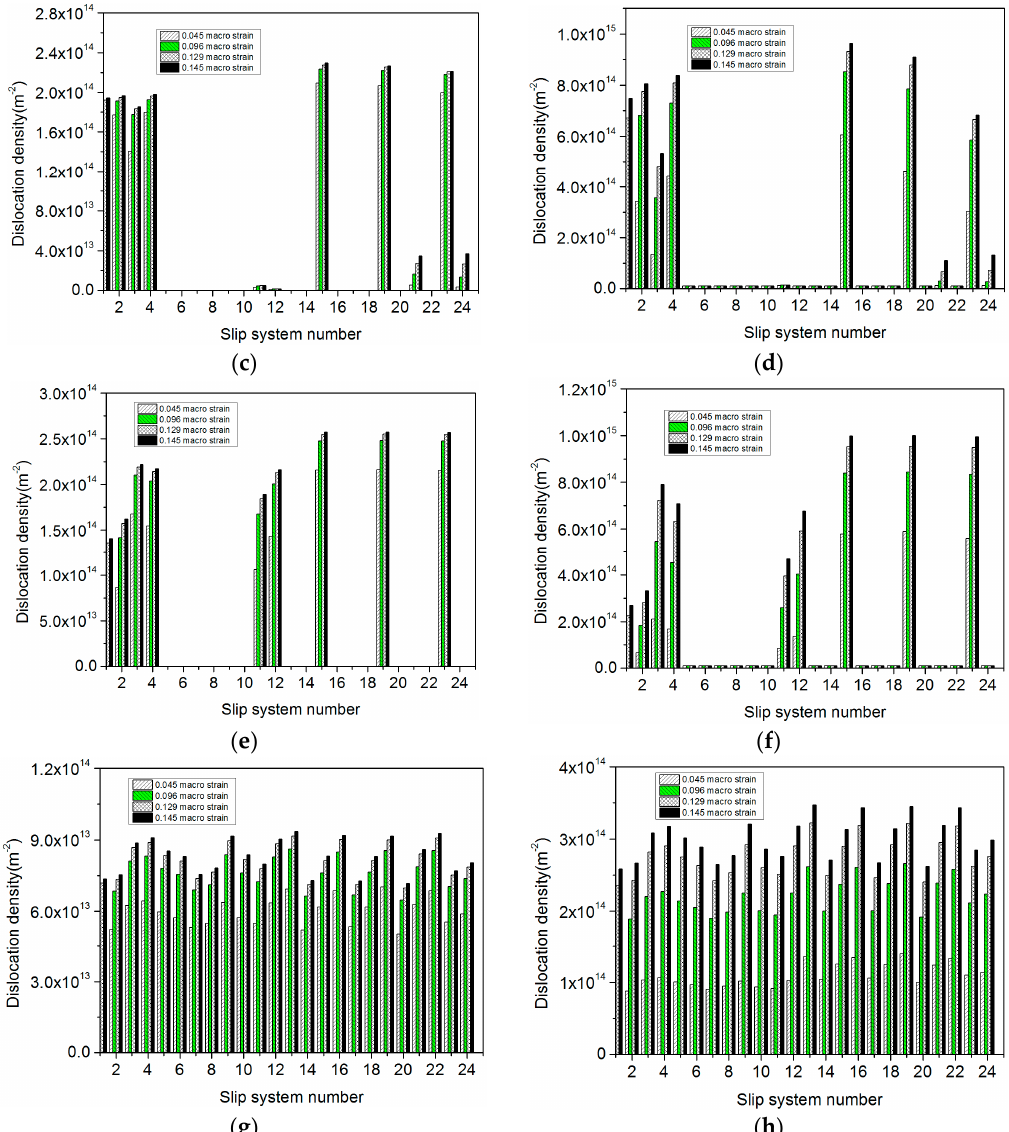
Figure 15. The dislocation density of each slip ‐ system with different macro strains. ( a ) Ferrite dislocation density of Rt ‐ C. ( b ) Martensite dislocation density of Rt ‐ C. ( c ) Ferrite dislocation density of {111} <112>. ( d ) Martensite dislocation density of {111} <112>. ( e ) Ferrite dislocation density of ~S. ( f ) Martensite dislocation density of ~S. ( g ) The average ferrite dislocation density for all grains. ( h ) The average martensite dislocation density for all grains.